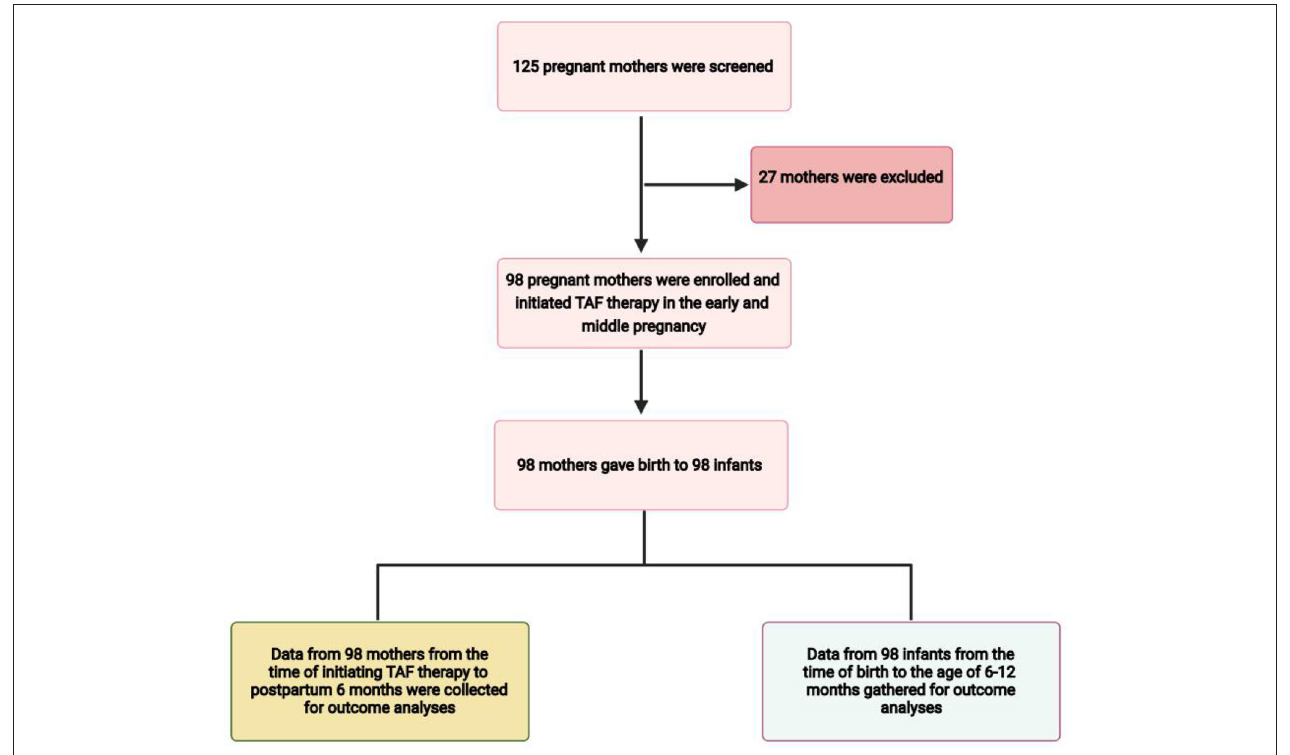
FIGURE 1 | Flow diagram of the